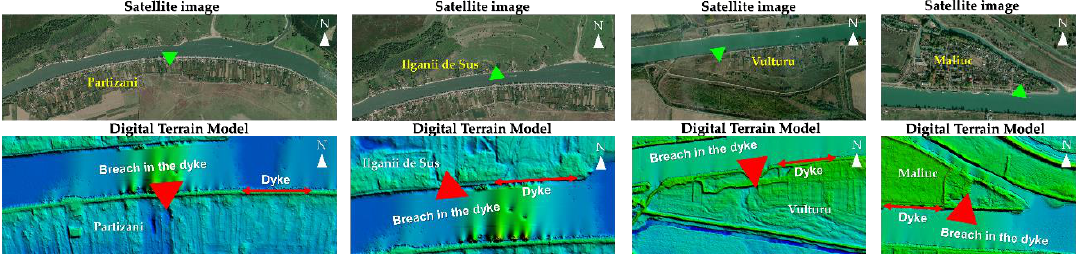
Figure 8. Rupture scenarios (breaches) in the dykes of the settlements Partizani, Ilganii de Sus, Vulturu, and Maliuc: the upper line of subfigures show the location of the breaches on ortophotomap, second line of subfigures shows the breaches in the dyke on DTM representation.